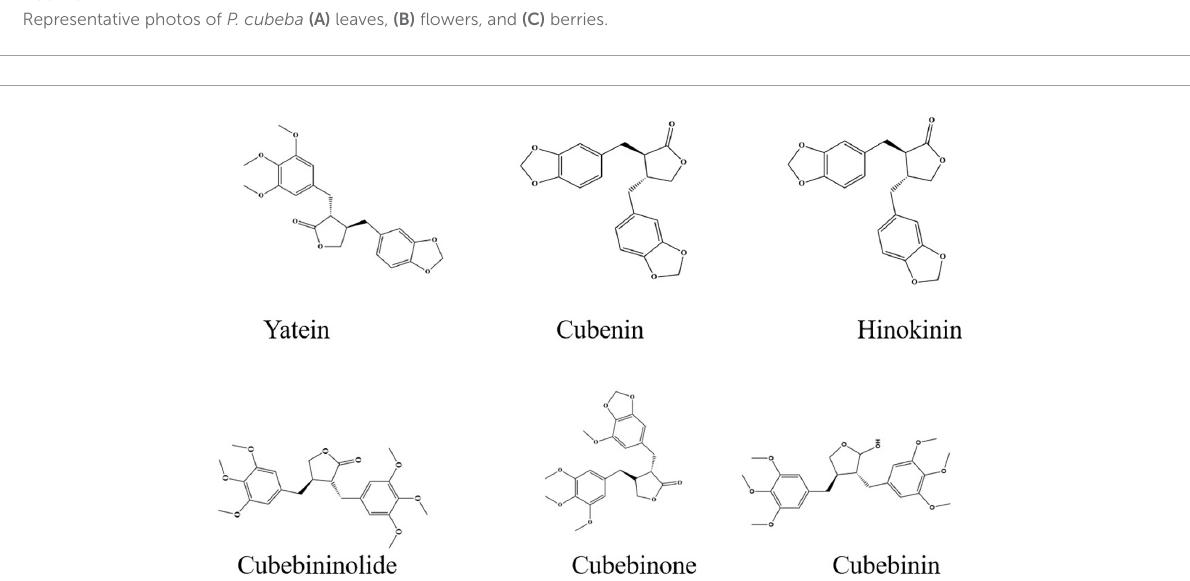
FIGURE4 Structure of the most predominant compounds from P.